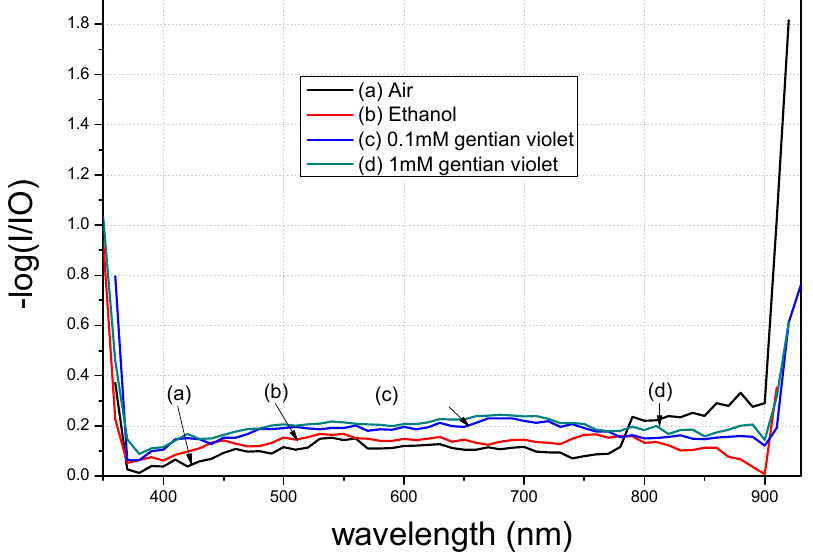
Figure 9. Transmittance of the modified fiber by APTMS.